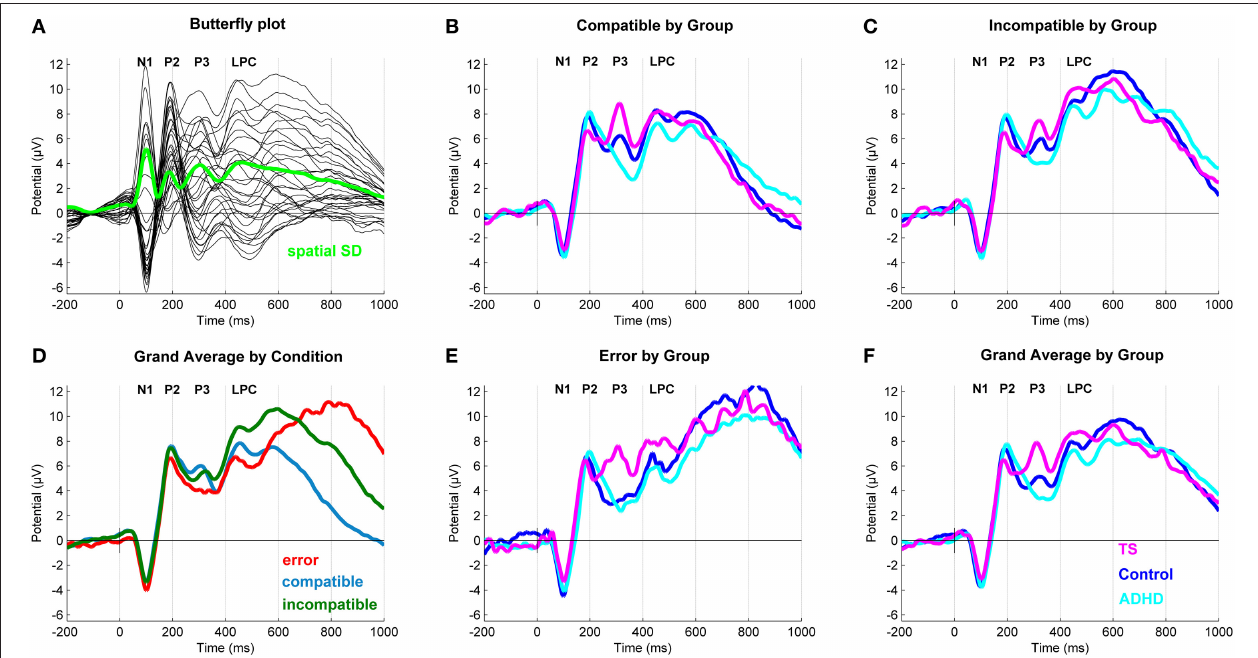
FIGURE 2 | Stimulus-locked event-related potentials (ERP). (A) Butterfly plot. Topographical distribution of the P3 component across outcomes. (D) Grand average ERP by Outcome at a central region of interest for compatible (blue), incompatible (green) and erroneous (red) trials. (B,C,E) Grand average ERPs at a central region of interest with a N1 (108ms), P2 (196ms), P3 (320ms), and a Late Positive Component (598ms) for compatible, incompatible and erroneous trials. (F) Grand average ERP by Group. Group differences for Tourette syndrome (TS) (pink), attention-deficit/hyperactivity disorder (ADHD) (turquoise) and control children (blue) at a central region of